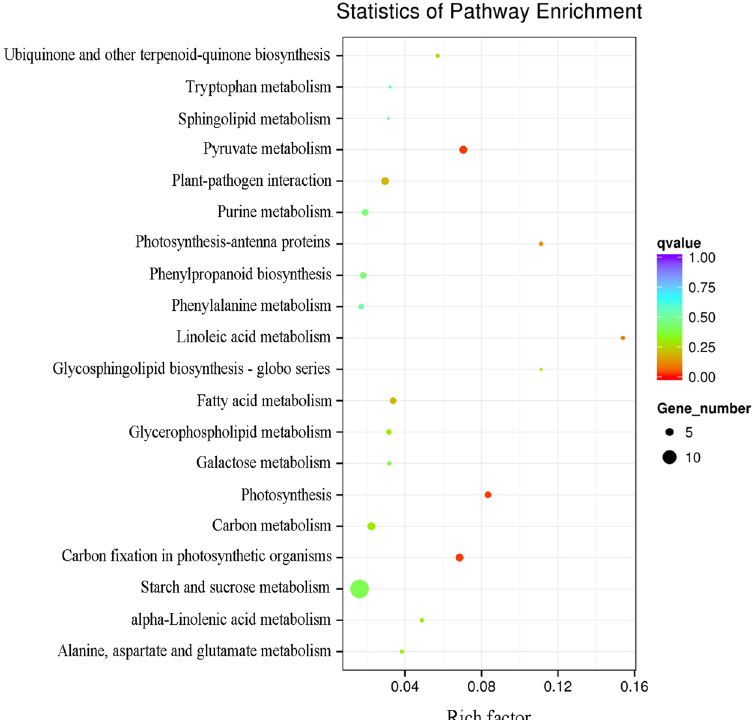
Figure 4. KEGG pathway enrichment analysis of DEGs between P and L + P treatment. The left Y-axis shows the KEGG pathway. The X-axis shows the Rich factor. The enrichment factor indicates the ratio of differential expression unigenes enriched in this pathway to the total number of annotated unigenes. The size and color of each point represents the number of genes enriched in a particular pathway and the q -values. A larger enrichment factor value and lower q -values indicates a greater degree of